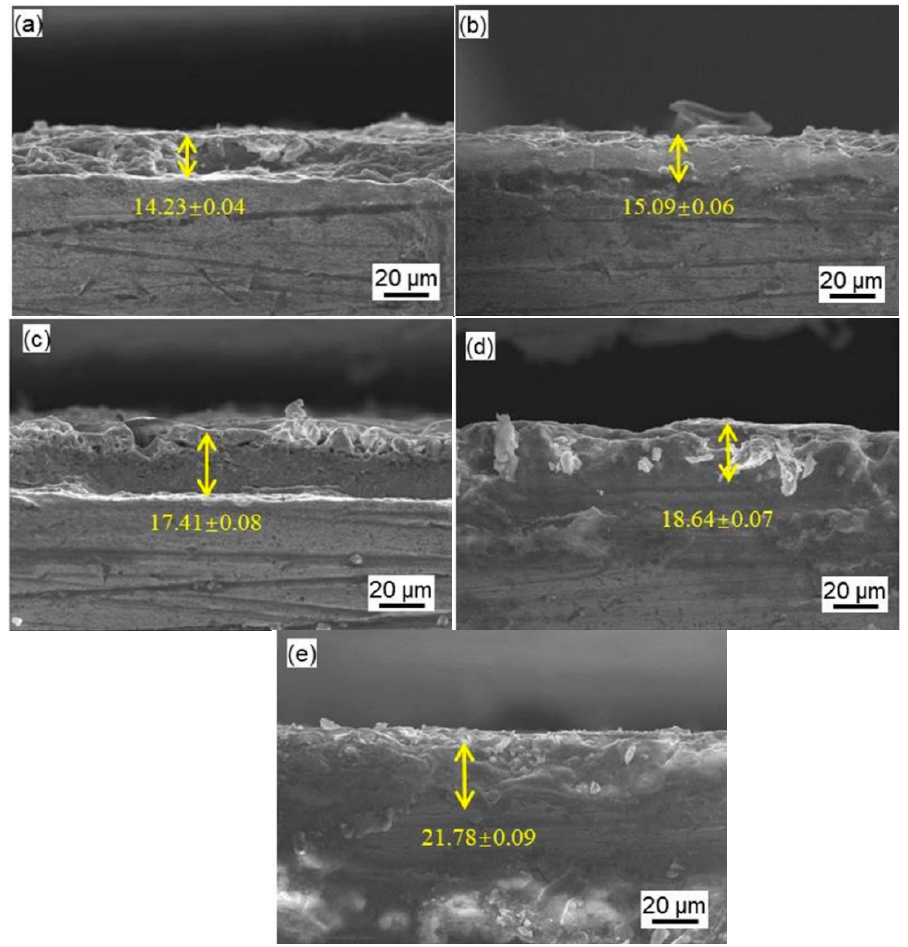
Figure 2. Cross-sectional SEM micrographs of MAO coating with different NaF concentrations: ( a ) 0.5 g/L; ( b ) 1 g/L; ( c ) 1.5 g/L; ( d ) 2 g/L; ( e ) 2.5 g/L.